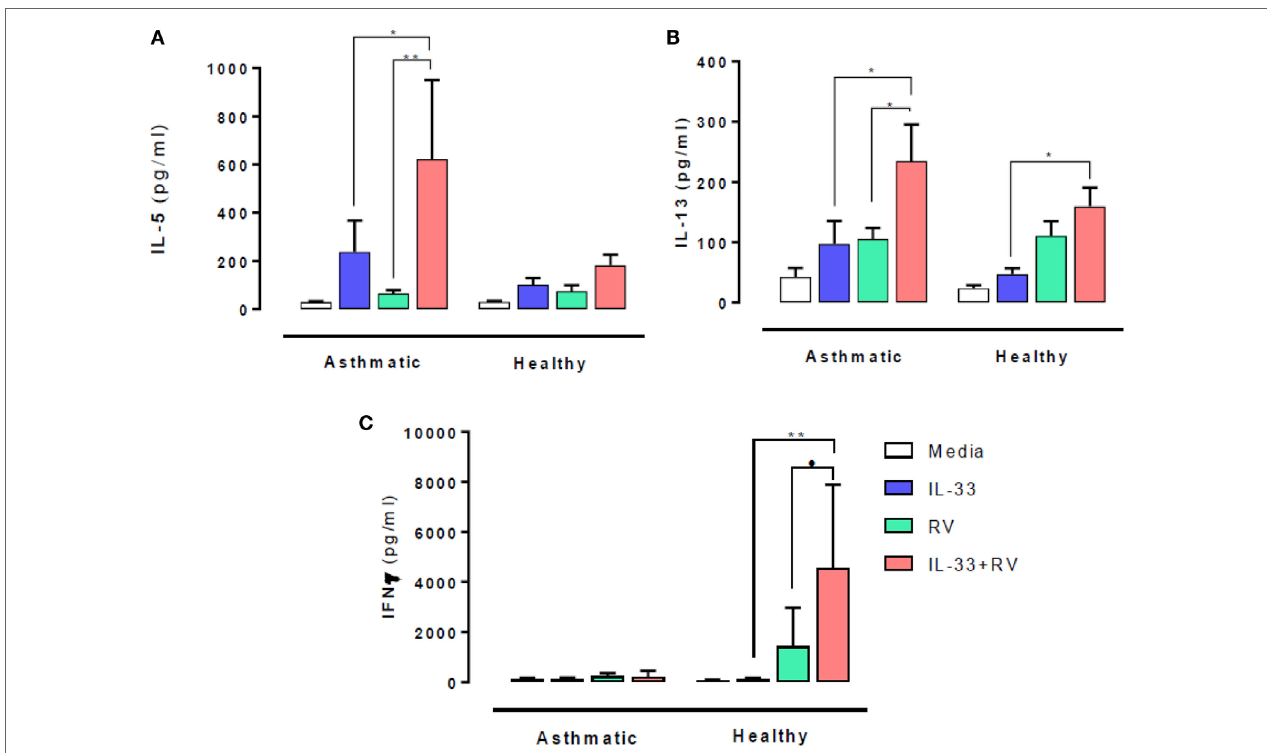
FigUre 1 | Effects of IL-33 on rhinovirus (RV)-induced type 1 and 2 cytokine release. PBMCs from people with allergic asthma ( n = 14) and non-allergic healthy controls ( n = 22) were pre-exposed to media or IL-33 for 6 h and then cultured in the absence or presence of RV for 5 days. IL-5 (a) , IL-13 (B) , and IFN γ (c) production have been measured by ELISA. Data are expressed as mean ( ± SEM). Abbreviations: PBMC, peripheral blood mononuclear cells; IL-33, interleukin 33; RV, rhinovirus 16; ns, not significant. * p < 0.05, ** p < 0.01, *** p <